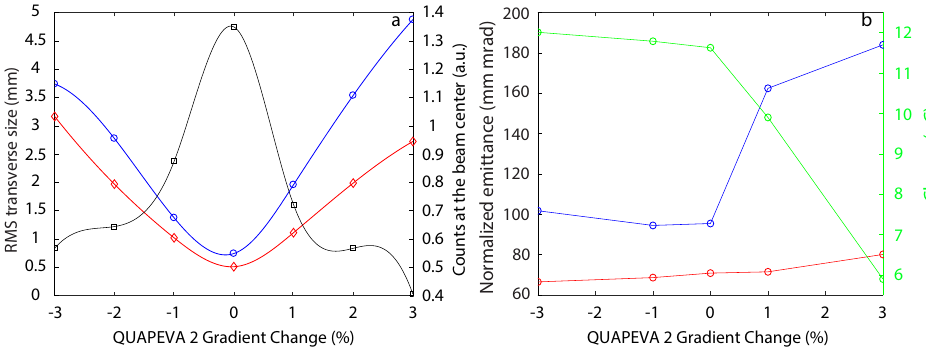
Figure 8. ( a ) Horizontal ( (cid:5) ) and vertical ( ◦ ) RMS beam size and counts at the center of the beam ( (cid:3) ) for the ”undulator entrance” optics (each point averaged over 5 repetitions of the simulation) and ( b ) beam vertical ( ◦ ) and horizontal ( ◦ ) normalized emittance and total charge ( ◦ ) at the undulator center for the optics ’undulator’, for the relative gradient change of QUAPEVA 2 using the low divergence initial beam distribution (Figure 2a and Table 1) with σ (cid:48) and (cid:101) x , i = (cid:101) z , i = 0.2